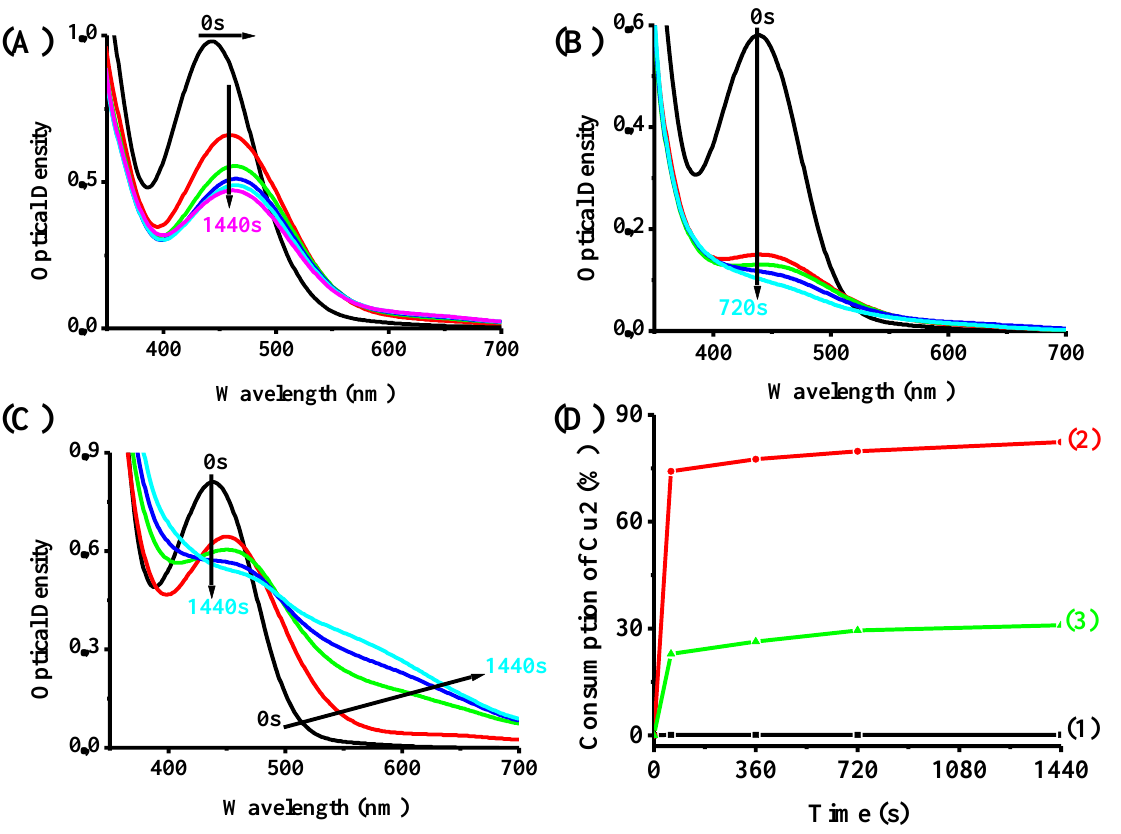
Figure 10. Photolysis experiments of ( A ) Cu1 with Iod salt (10 − 2 M), ( B ) Cu2 with Iod salt (10 − 2 M) and ( C ) Cu2/Iod/NPG (10 − 2 M) upon exposure to LED at 405 nm. ( D ) Consumption percentage of Cu2: (1) alone, (2) with Iod, (3) with Iod/NPG.